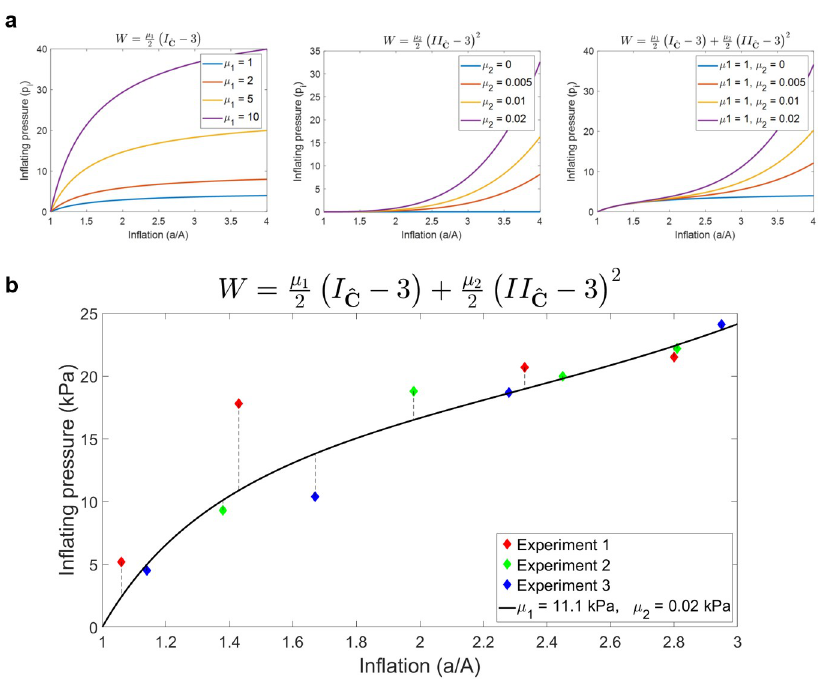
Fig 9. Fitting the experimental pressure data. (a) Example family of curves representing the inflating pressure obtained from the linear (left) and quadratic (centre) term of the modified Mooney-Rivlin law employed. The combined contributions generate a characteristic family of S-shaped curves (right). (b) The modified Mooney-Rivlin model provides a good approximation of the pressure data obtained from the three replicates of the inflation experiment ( r 2 = 0.86).